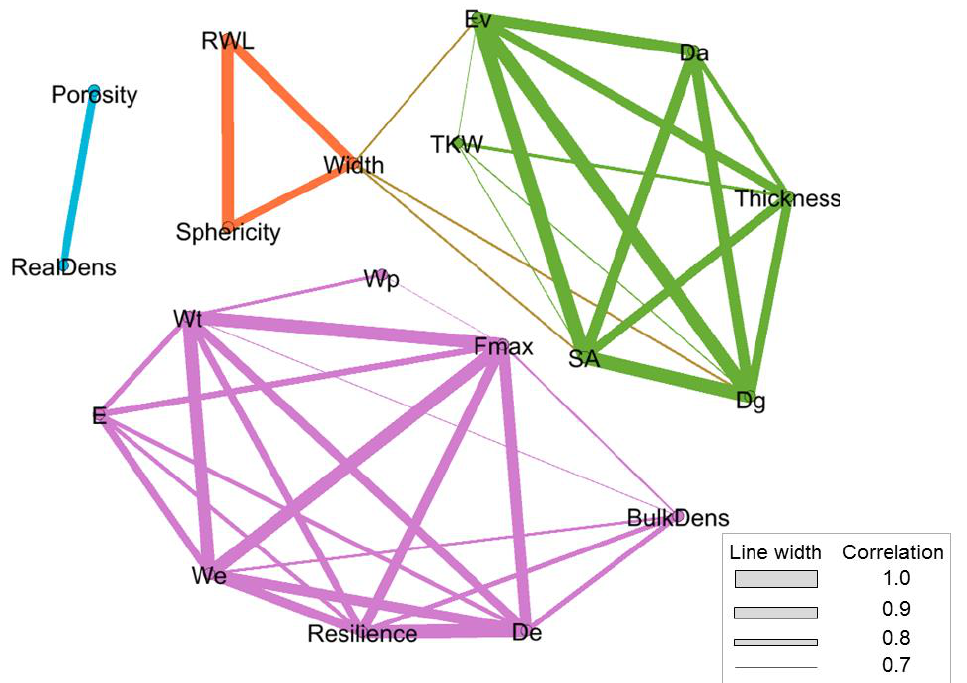
Figure 5. Correlation matrix among the evaluated parameters in three cereal types at two moisture levels (12% and 16%) demonstrating two main clusters with the higher relationship, where mechanical and viscoelastic properties stand out. The width bars represent the approximate p -value.